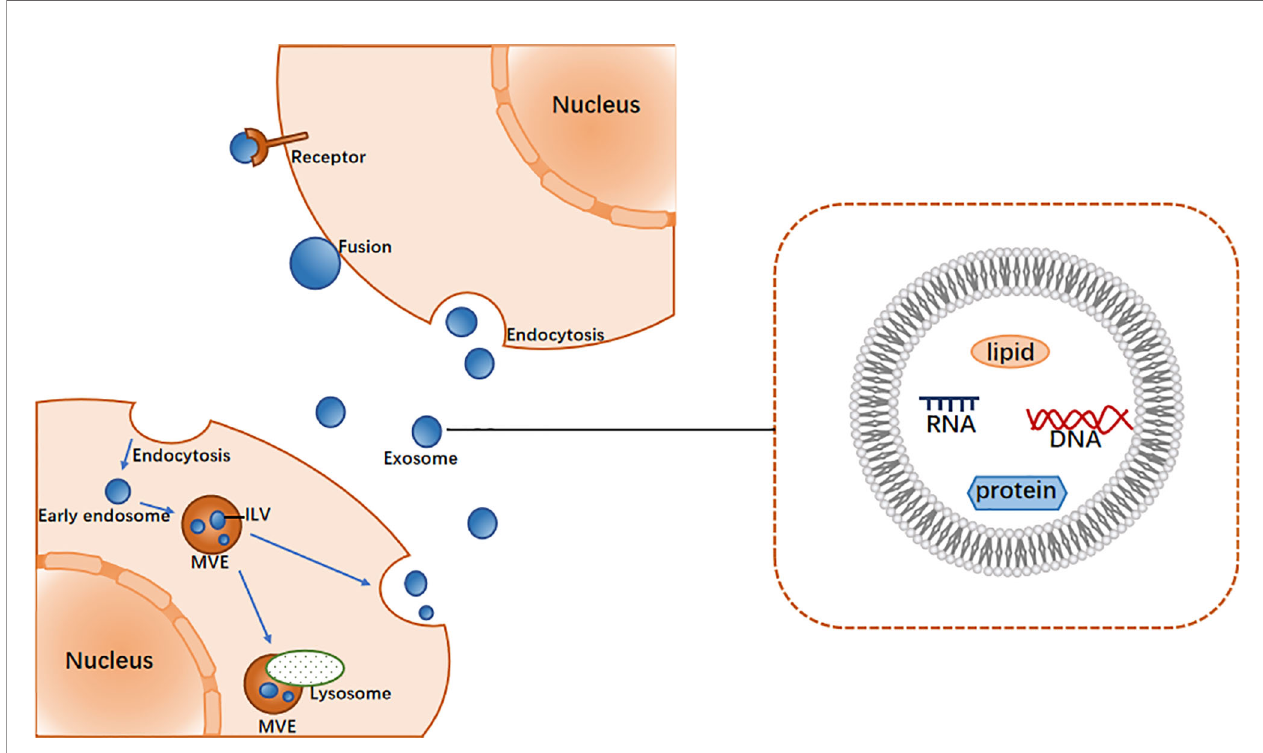
FIGURE 1 | The main process of exosome biogenesis and